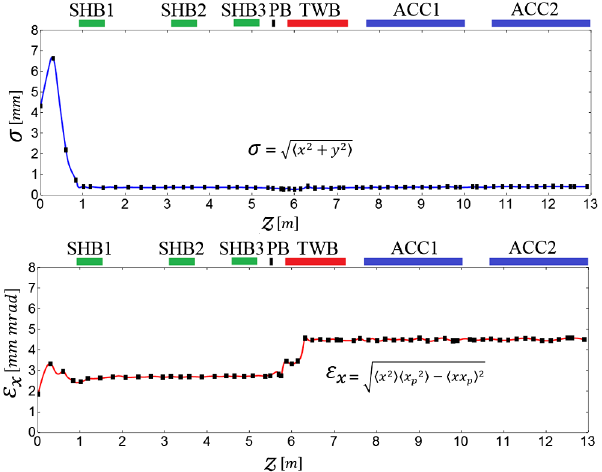
FIG. 14. PARMELA simulation results for the variations of the beam rms radius (top panel) and the beam emittance (bottom panel) within the focusing channel designed for the CLIC drive beam